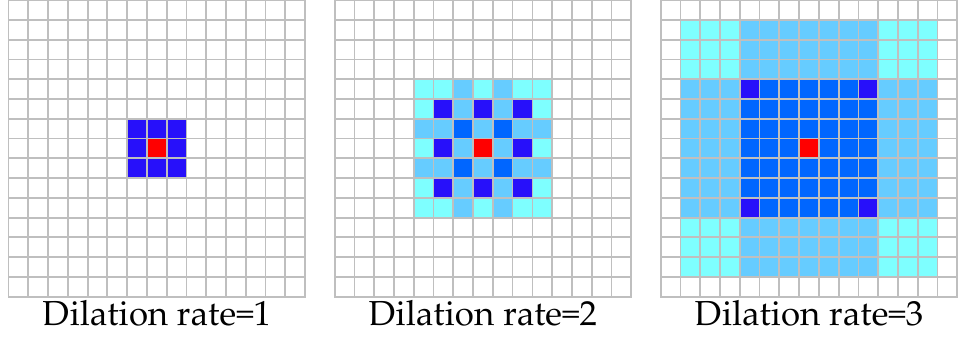
Figure 6. Illustration of the DConv